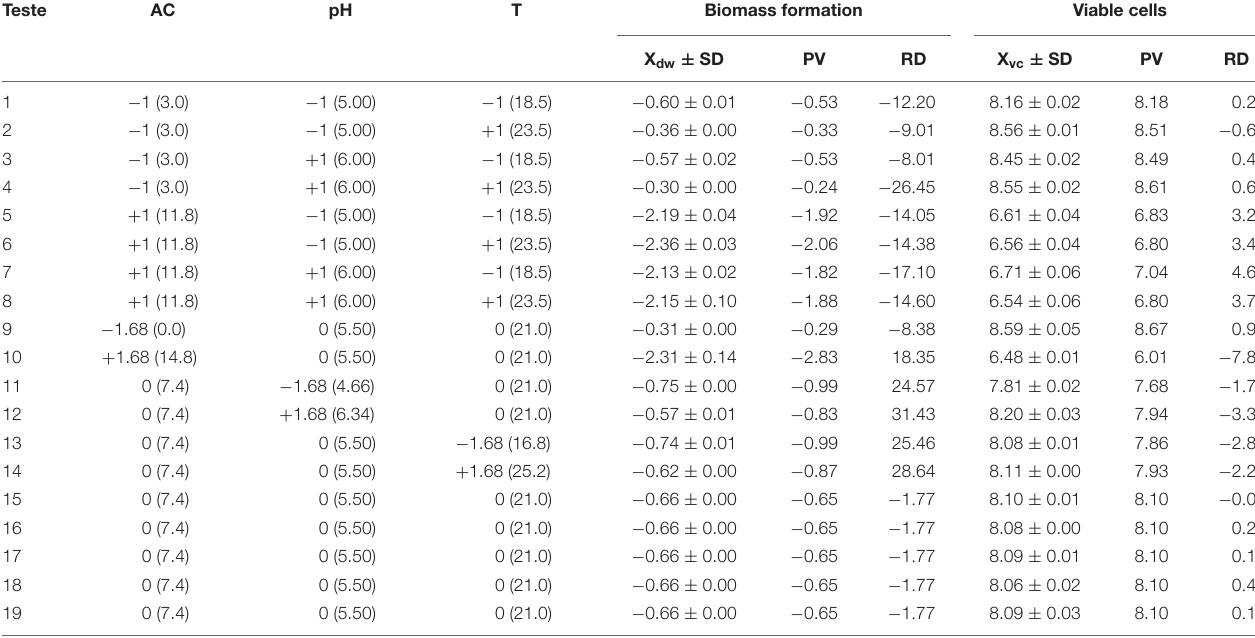
TABLE 2 | Central composite rotatable design (CCRD 2 3 ) for S. boulardii